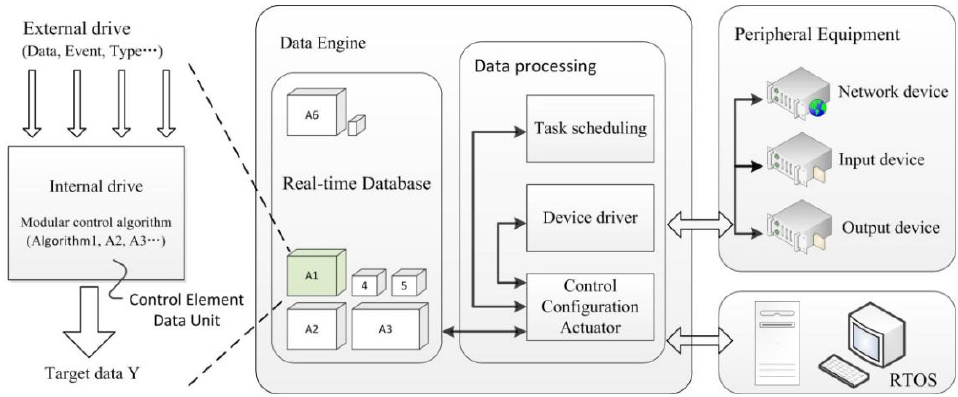
Figure 1. Control component modeling and data engine structure.